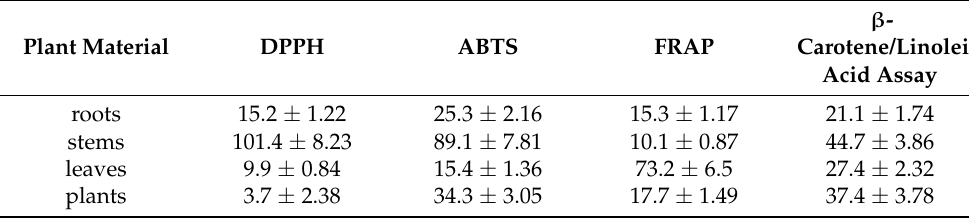
Figure 4. ( A ) Putative interactions between caftaric acid and lanosterol 14 α -demethylase (PDB ID: 5TZ1). Free energy binding and a ffi nity are − 6.8 Kcal/mol and 10.5 µM, respectively. ( B ) Putative interactions between ketoconazole with lanosterol 14 α -demethylase (PDB ID: 5TZ1). Free energy binding and a ffi nity are − 9.6 Kcal/mol and 0.1 µM, respectively.